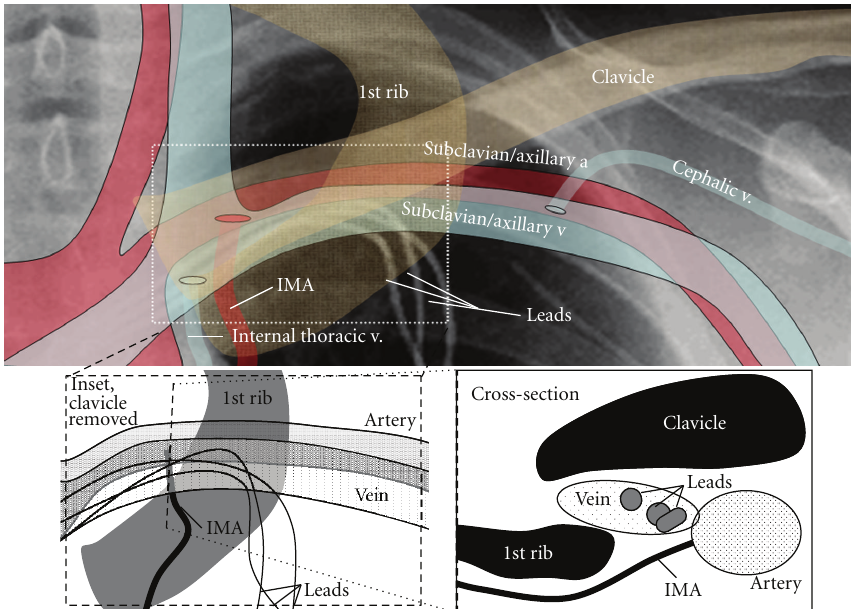
Figure 3: The relationship of the clavicle, first rib, IMA, and subclavian vessels is shown. A common “problem area” for extraction is the region of intersection of the clavicle and first rib (dashed white box). This region is a common site of lead insertion and can have significant fibrosis, calcification, and lead angulation (inset panel). Lead angulation is a main reason for extraction sheaths to deviate from their coaxial course and thus cause trauma to adjacent structures. A cross-section schematic at the point of IMA takeo ff from the subclavian artery reveals its proximity to the adjacent vein and its potential for trauma (right lower